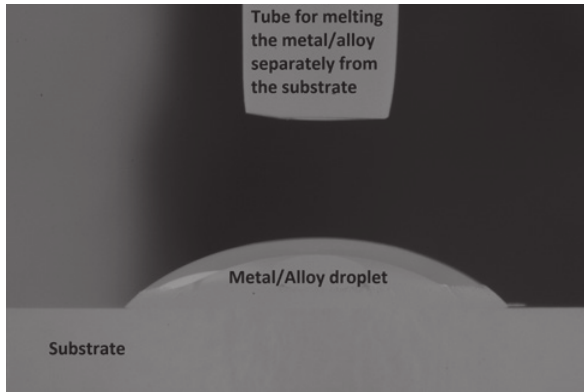
Fig. 4: The droplet form in experiment 8 (FeMo3.5-TiC B) after 10 min holding at 1823 K